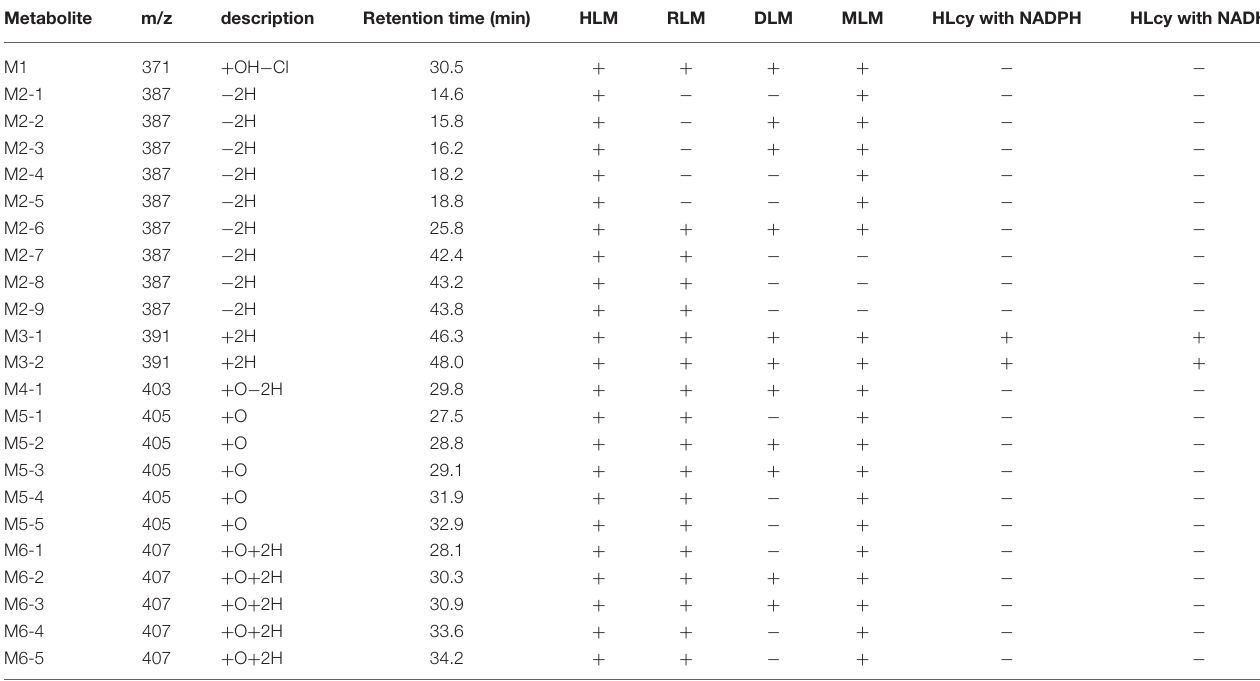
TABLE 2 | F18 metabolites detected in HLM, RLM, DLM, MLM, and HLcy after incubation with a substrate concentration of 50 µ M for 1 h.